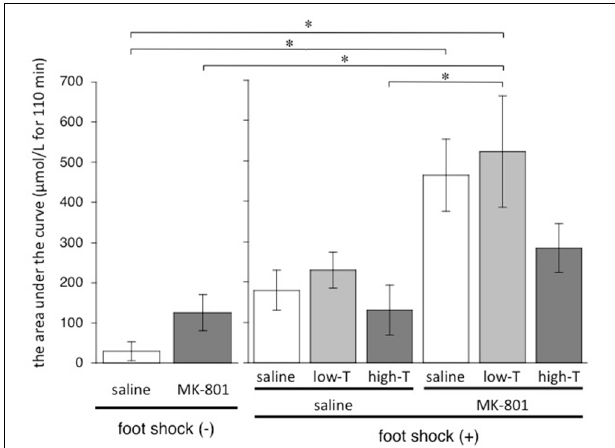
FIGURE 4 | Total increase of lactate after injection (from time 0 to time 110min) calculated by sum of (each eLAC concentration—basal concentration of eLAC). Basal concentration of eLAC is the average of eLAC during the period preceding the last injection (four measurements performed every 5min). Asterisk showed p < 0 . 05 between